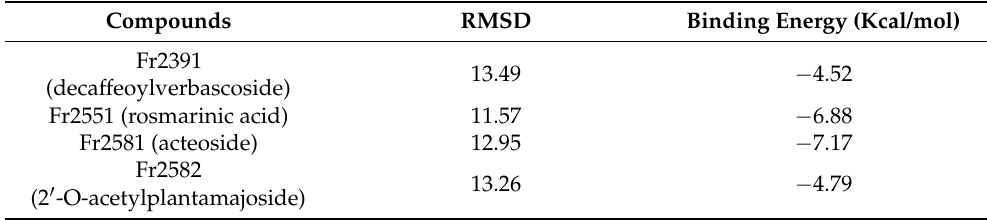
Table 2. Binding energy of Fr2391, Fr2551, Fr2581, and Fr2582 in HO-1 (PDB ID: